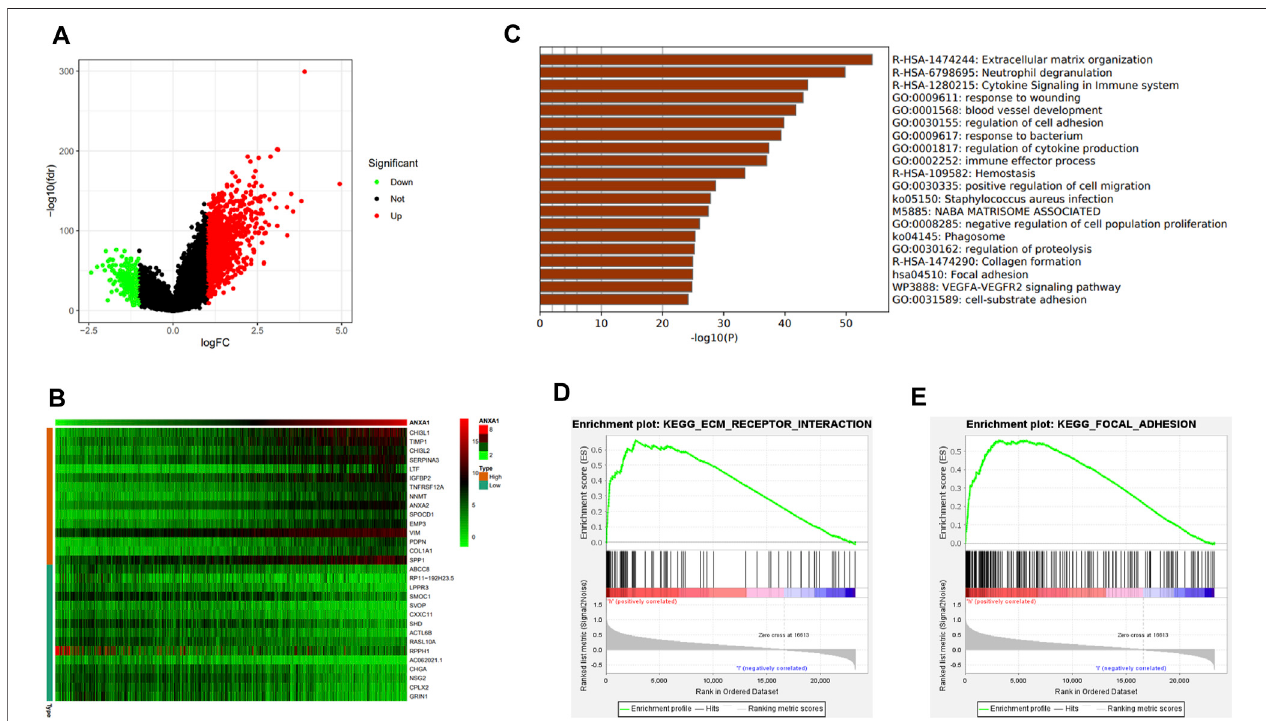
FIGURE 5 | DEG analysis and ANXA1 gene mechanism analysis. (A) Visual volcano plot of differentially expressed genes. (B) Heat map of DEGs was drawn, showing DEGs that were signi fi cantly upregulated and signi fi cantly downregulated. (C) Visual heat map for the mechanism analysis of DEGs on the Metascape online website. (D,E) Enriched ECM – receptor interaction and focal adhesion signal pathway by